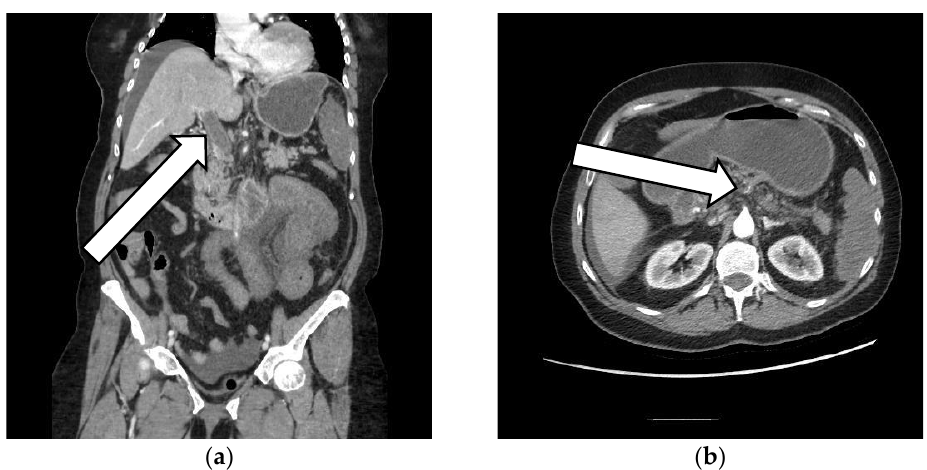
Figure 3. CT scan at admission. ( a ) Arrow is pointing toward the portal vein; one can appreciate the absence of contrast opacification of the portal vein and the absence of opacification of intrahepatic portal branches. ( b ) Arrow is pointing toward the splenic artery; one can appreciate the thrombosis of the splenic artery with extended spleen infarction.